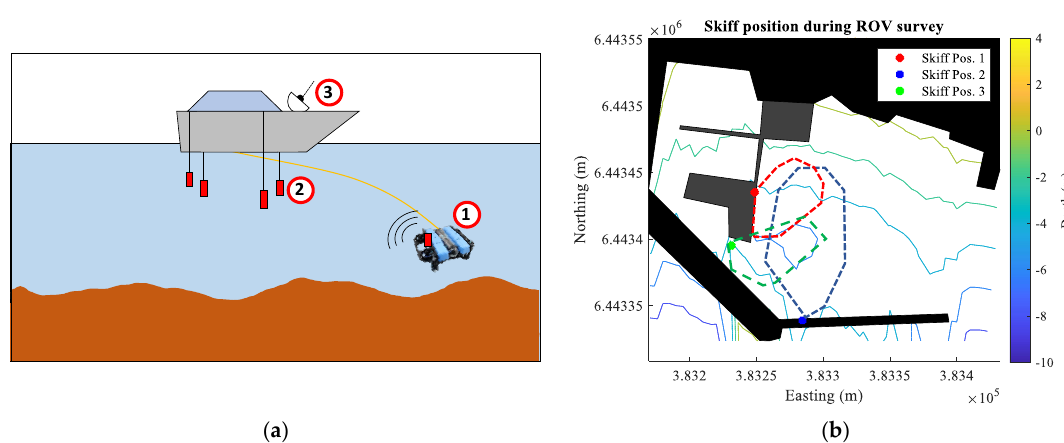
Figure 8. ( a ) ROV operation overview (ROV equipped with acoustic transmitter (1), boat equipped with acoustic receivers (2) and GNSS antenna (3) for global reference); ( b ) boat position during ROV operation.